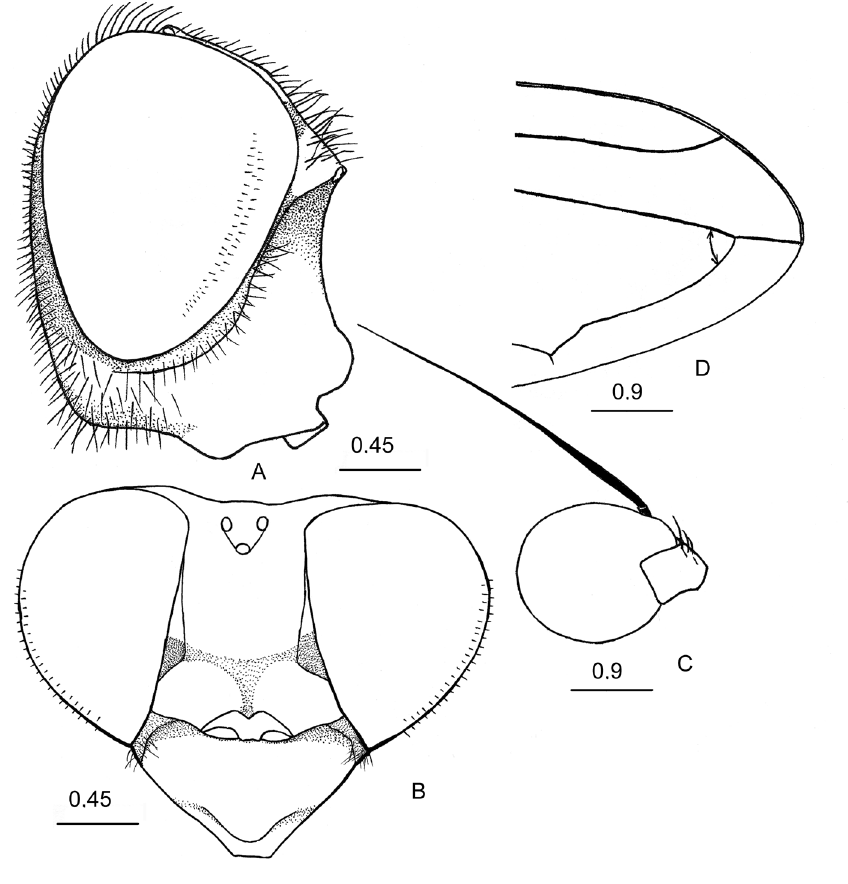
Fig. 22. Cheilosia flavigena sp. nov., holotype, ♀ (CNC). A . Head, lateral view. B . Head, dorsal view. C . Antenna, lateral view of pedicel and basoflagellomere. D . Tip of wing. Scale bars indicated in